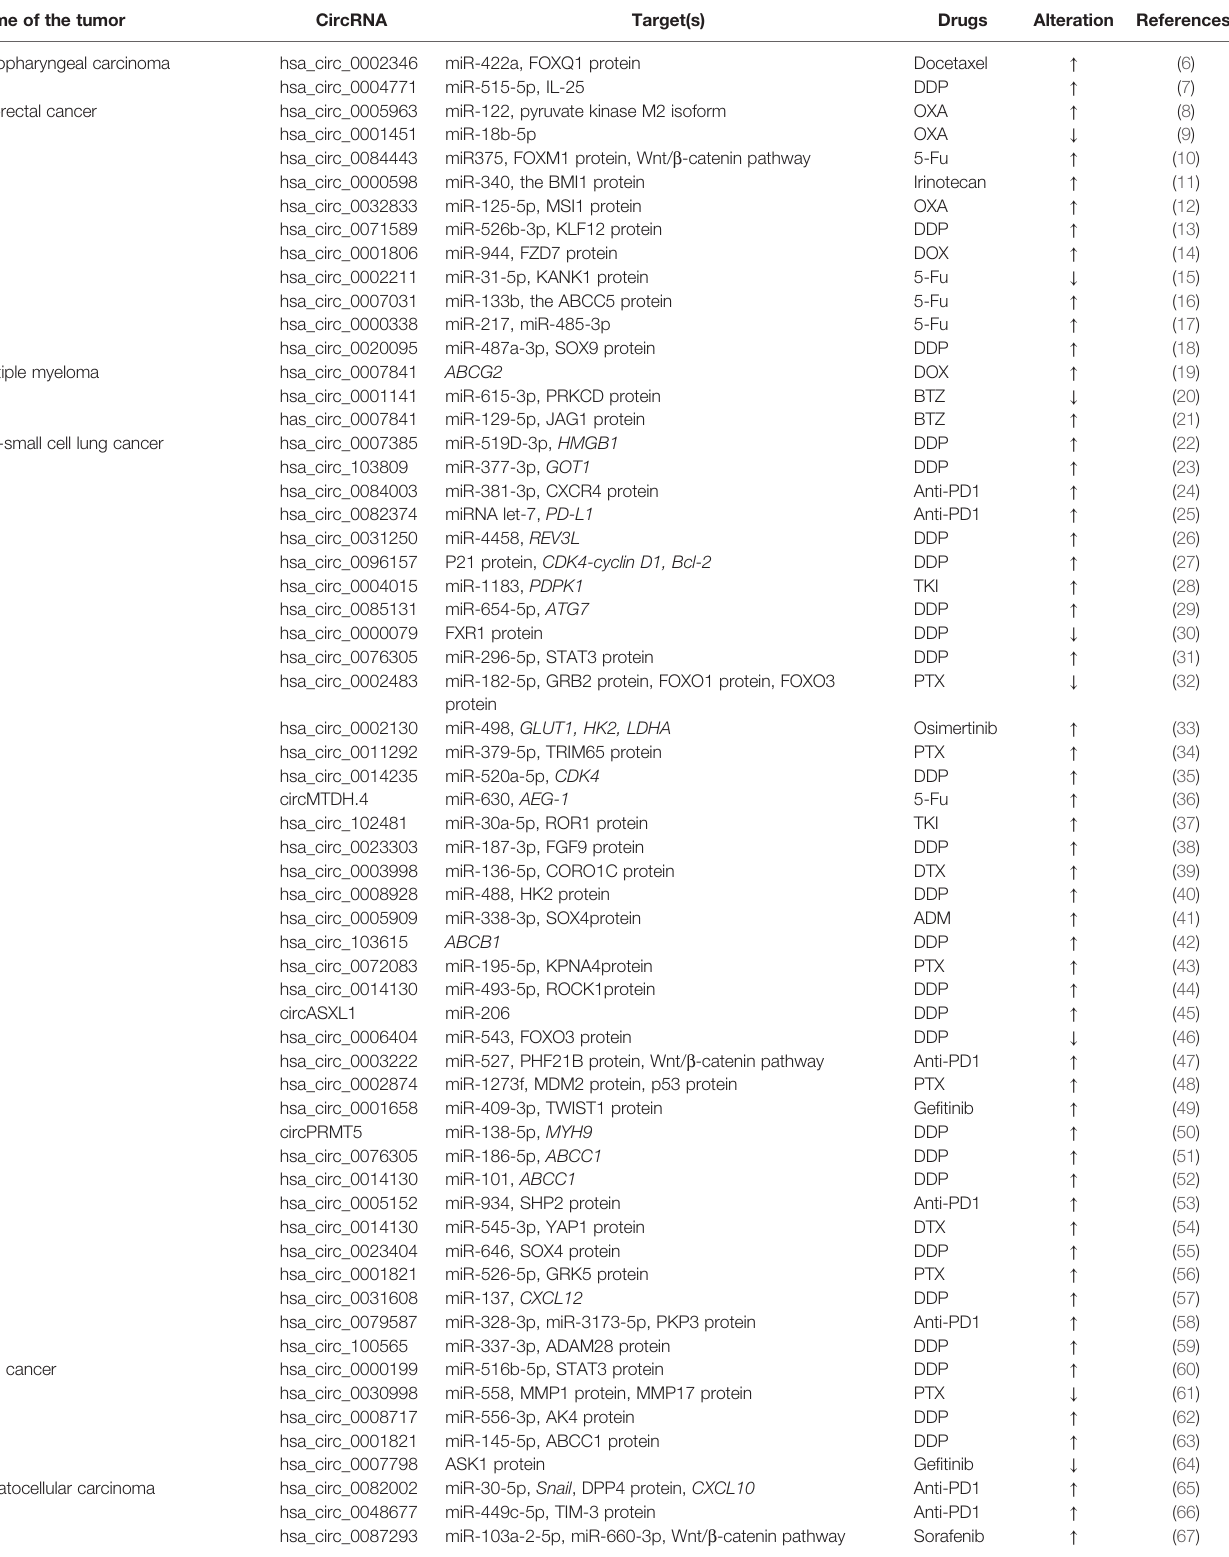
TABLE 1 | CircRNAs in tumor drug